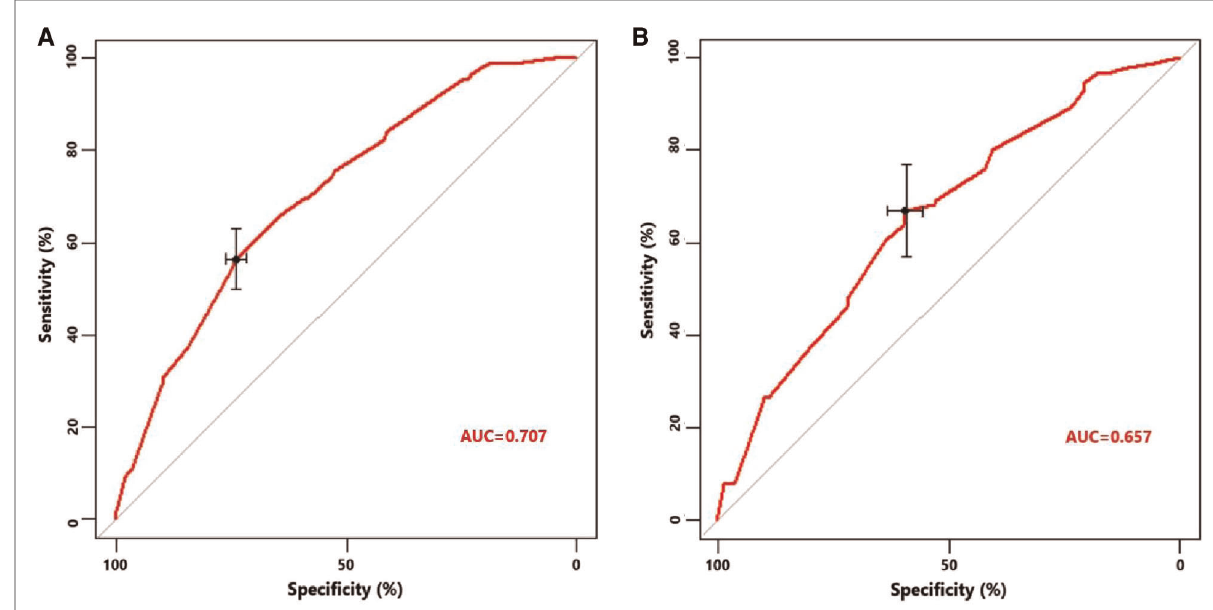
FIGURE 3 ( A ) Receiver operating characteristic curve of the constructed nomogram for predicting liver metastasis in the training cohort. ( B) Receiver operating characteristic curve of the constructed nomogram for predicting liver metastasis in the testing cohort.